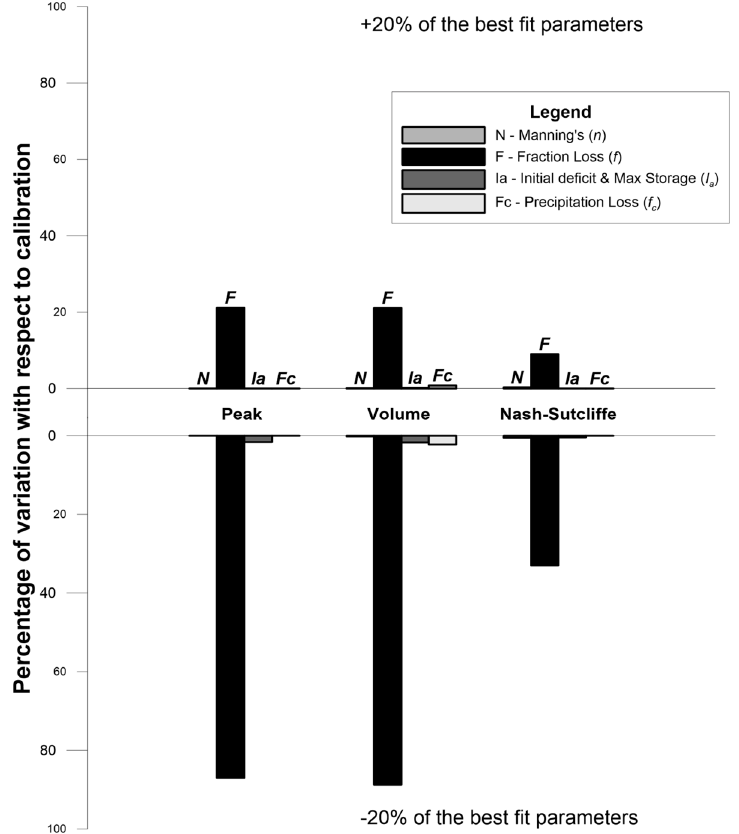
Figure 6. Results of the sensitivity analysis. The impact of changing each parameter on the simulation results, as expressed in percent variation with respect to the respective optimum simulated value.